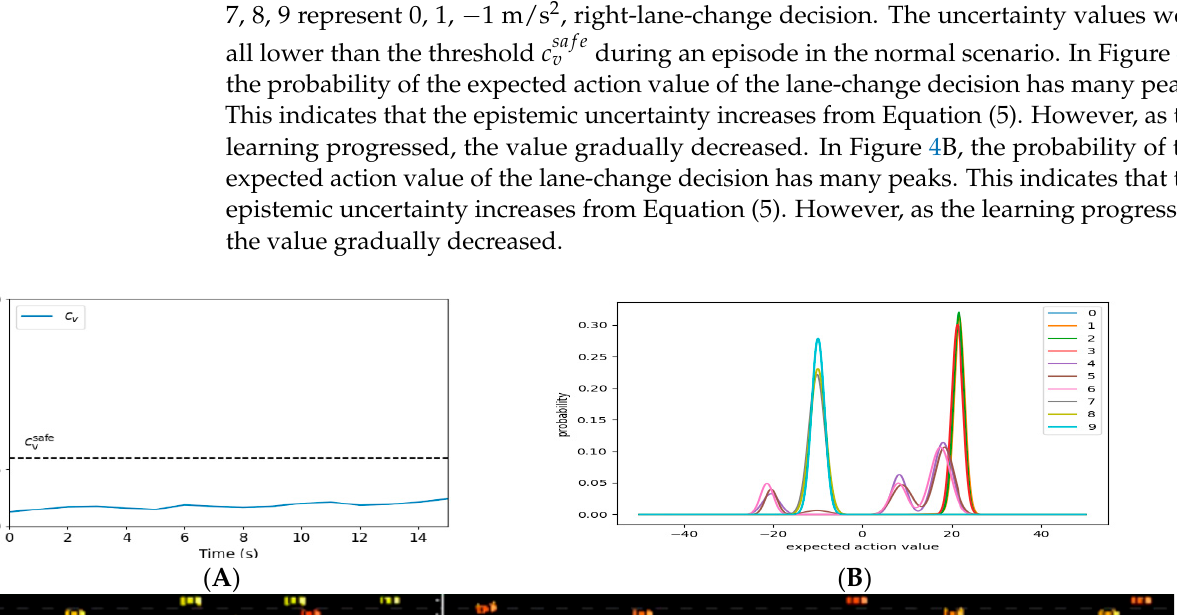
8 of 13 ( C ) Figure 3. Three types of scenarios: ( A ) normal scenario, ( B ) stop scenario, and ( C ) speeding scenario. Green vehicle is ego vehicle, white vehicle is stationary vehicle, and purple vehicle is speeding vehicle. The other nearby vehicles are closer to red as the speed increases. All environments were limited to three-lane highways. In scenario A (normal scenario), yellow and red represented vehicles at 15 to 35 m/s. Meanwhile, a white vehicle existed in scenario B (stop scenario), whereas a purple vehicle with a 55 m/s speed